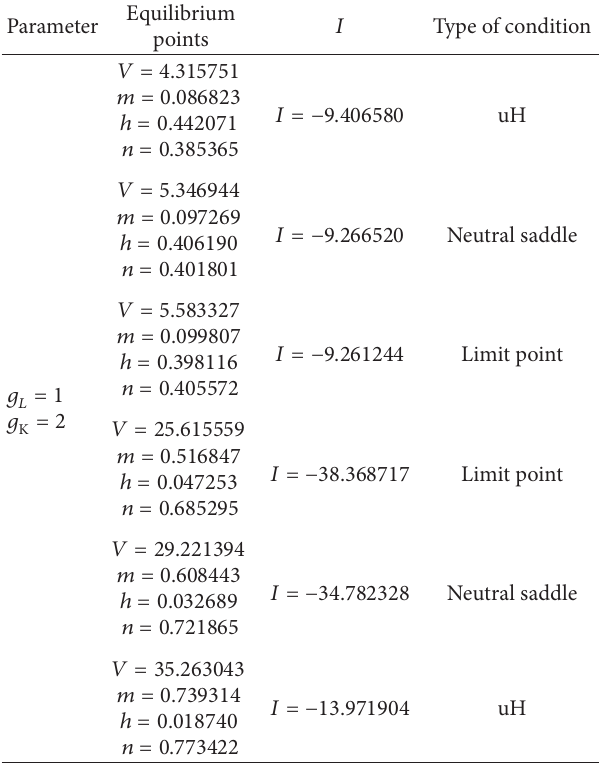
Table 3: Bifurcation analysis results derived by the Matcont soft-